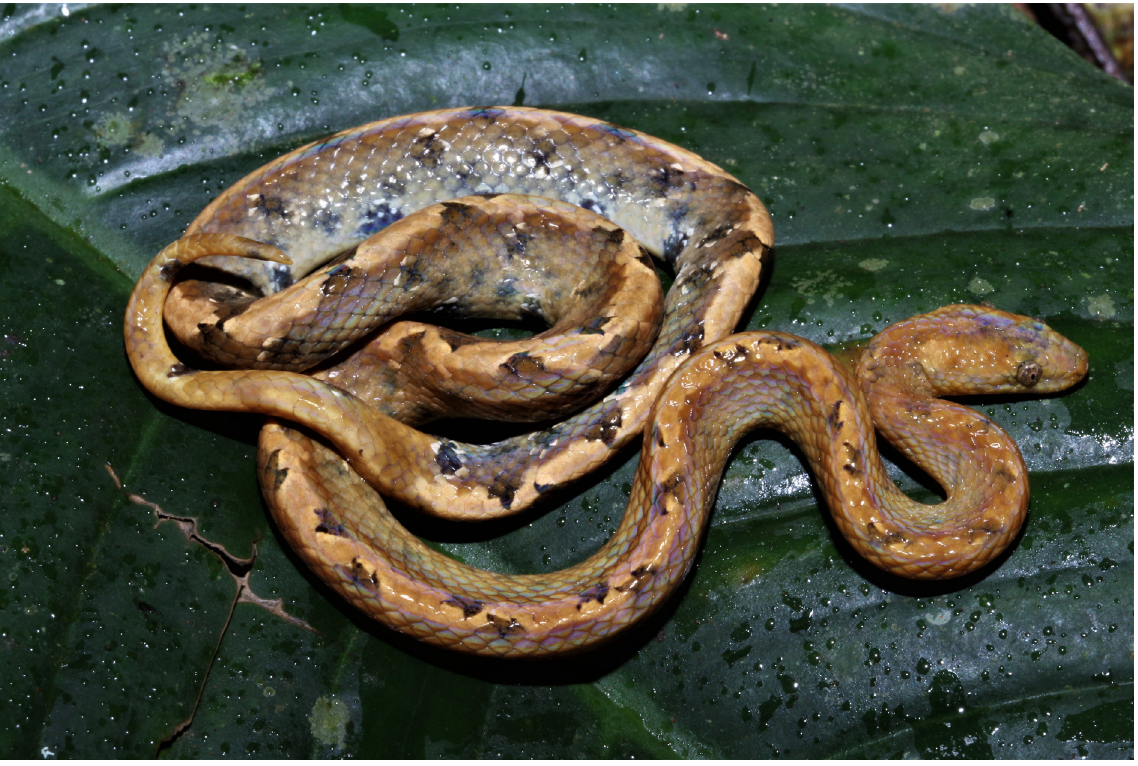
Fig. 17. An extralimital tropidophiid from mainland South America, Tropidophis paucisquamis (Müller in Schenkel, 1901), from Ubatuba, São Paulo, Brazil. Photograph credit: Edelcio